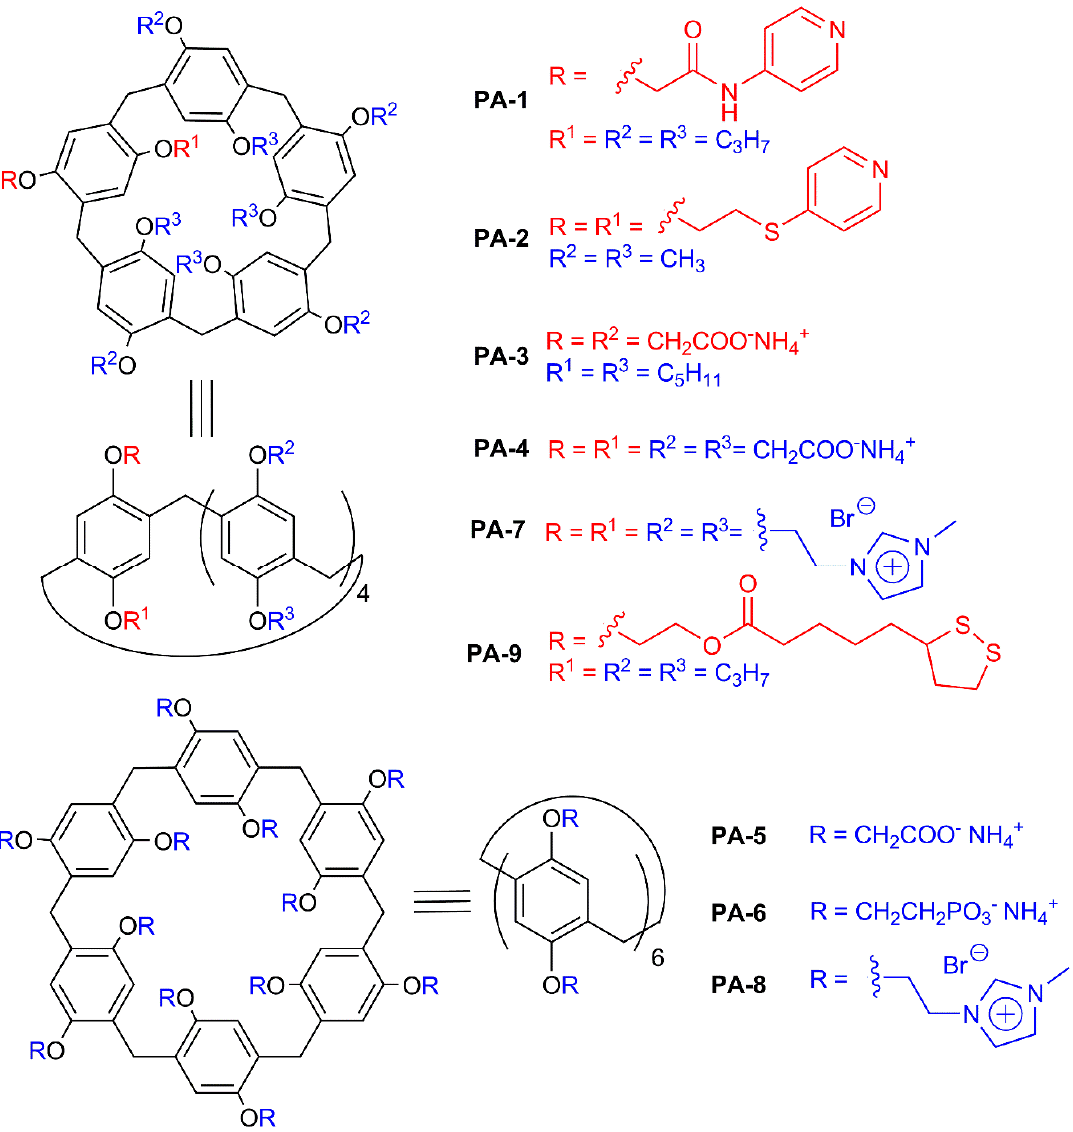
Figure 8. Structures of pillar[n]arenes.